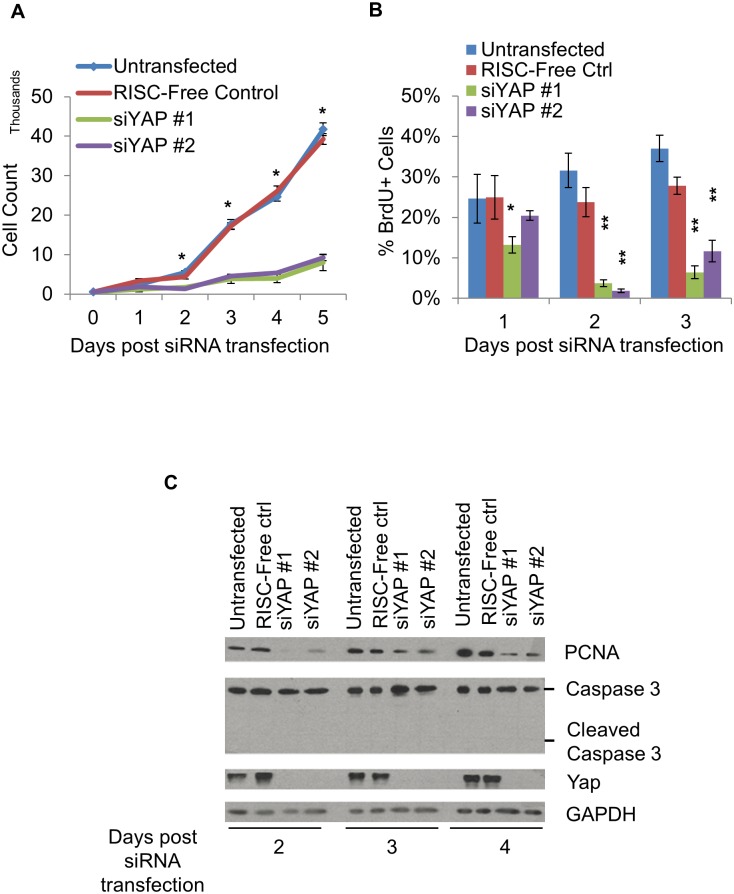
Deletion of YAP results in decreased HUVEC cell number.A. HUVEC cell number plotted against time after siRNA transfection. Untransfected and RISC-free siRNA were the control groups. Cells were counted on an Accuri C6 flow cytometer at 24 h intervals after transfection. There was a significant decrease in cell number in siYAP treated HUVECs compared to control HUVECs 48 h post-knockdown and at later time-points. Data are plotted as mean +/- standard error. N = 3 for each timepoint; *, p < 0.001. B. Quantification of BrdU+ HUVECs upon siYAP transfection. Cells were incubated with BrdU for 30 min and then stained with a BrdU antibody for visualization and quantification (plotted as the ratio of BrdU+ cells as a percent of total cells counted). Significantly fewer BrdU+ HUVECs were detected in siYAP-treated cells. Error bars indicate standard errors. P-values reflect differences compared to RISC-free control. *, p < 0.04; **, p < 0.007. C. Immunoblot (IB) assessing the levels of PCNA, CASPASE3, cleavage CASPASE3 in control and YAP knockdown (YAP-KD) cells. Protein samples were collected on d 1, 2 or 3 post-siRNA transfection and analyzed by western blot. No CASPASE3 cleavage was detected on d 2, 3 or 4, suggesting that YAP knockdown did not affect cell survival. See also S1 and S2 Figs.